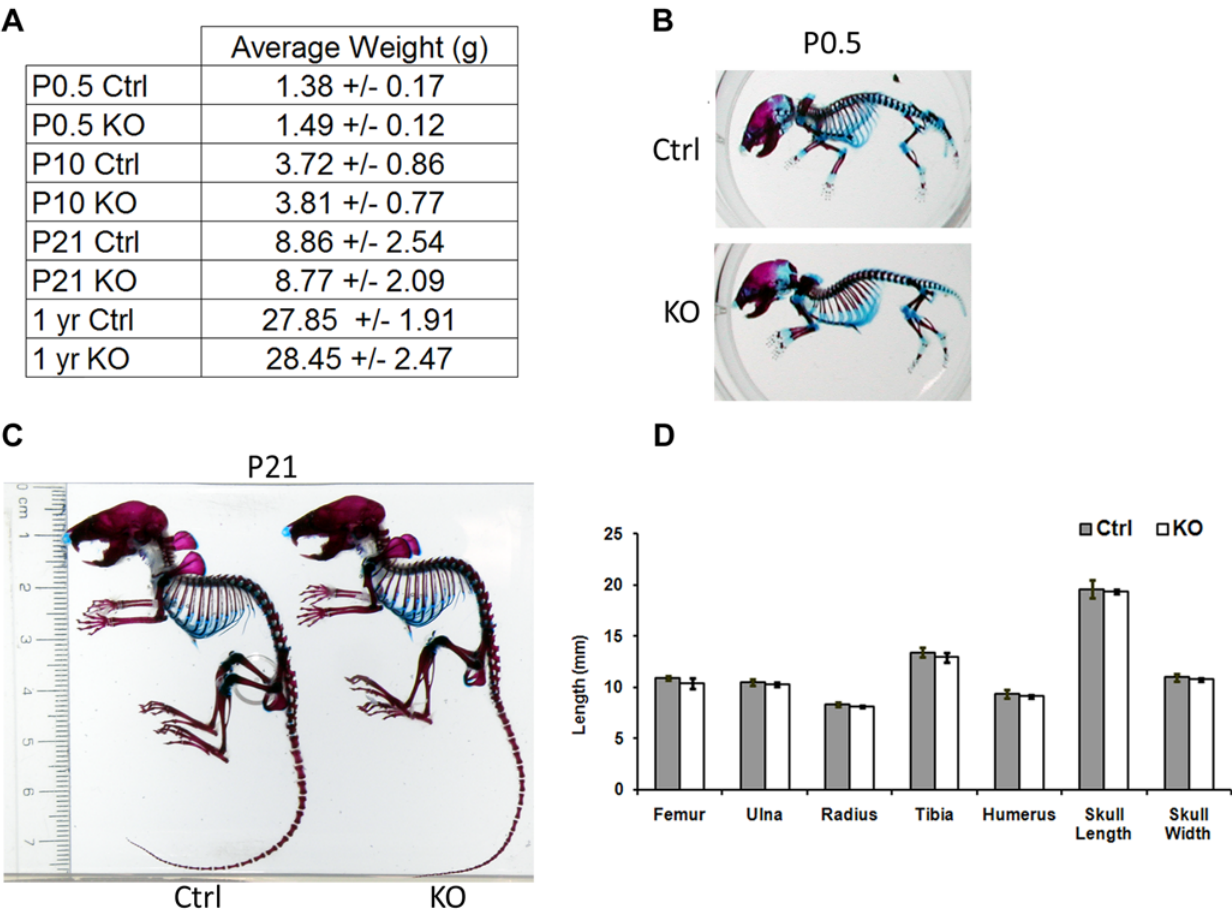
Figure 3. Effects of ATRX loss-of-function on growth and development of the skeleton. (A) Weight measurements from control and KO mice. No differences were seen in the growth of Atrx Col2Cre mice compared to control littermates, and weight gain was normal at all stages of development. (B, C) Skeletal stains of newborn and p21 control and KO mice showing cartilage (blue) and bone (red) proportions. Extent of limb ossification and skeletal proportions between control and mutant pups were unaffected at birth and at three weeks (D) Long bone lengths and skull proportions were measured from four control/KO littermate pairs at p21, and found to be unaffected by ATRX loss.